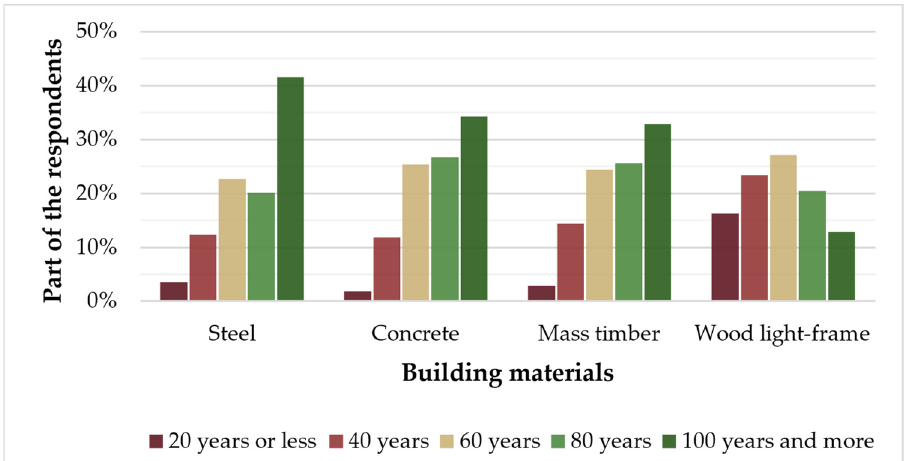
Figure 4. Perceived lifespan of building materials.